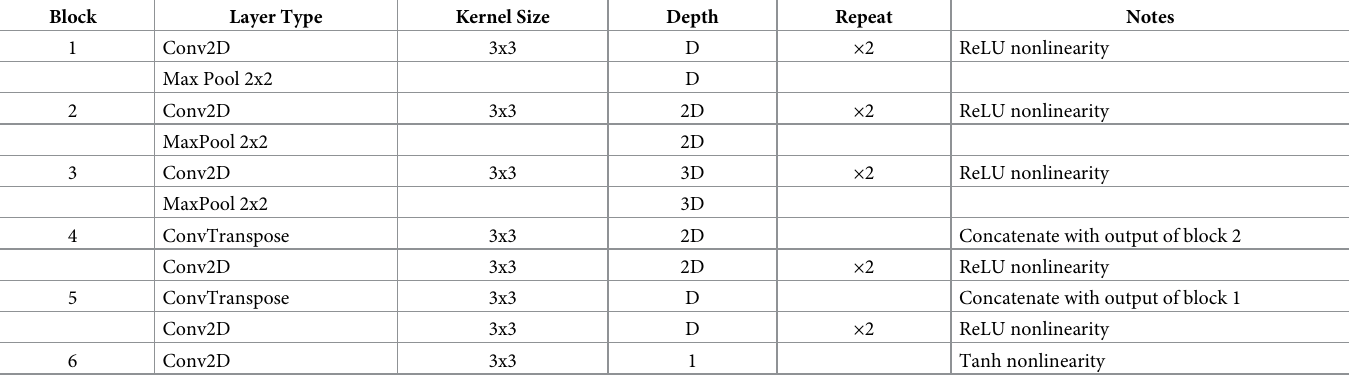
Table 2. U-Net Model Architecture. U-Net architecture used for the experiments in Table 1. D specifies the base level of channels; we considered experiments with D = 2, 4, 8, 16. Block Layer